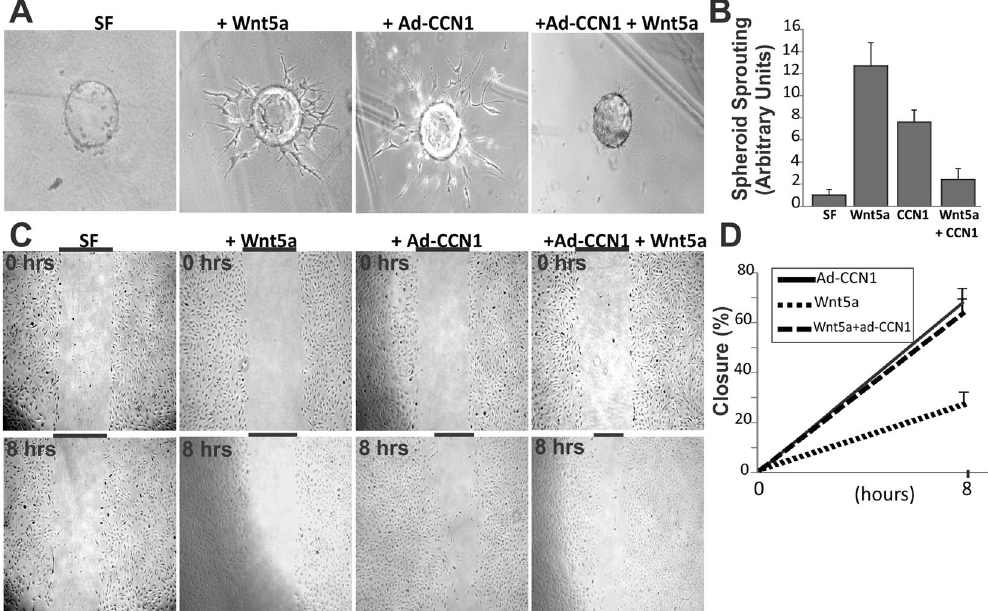
Figure 6. Functional and regulatory relationship between CCN1 and Wnt5a in ECs. ( A , B ) ECs were transduced with Ad-CCN1 or Ad-luc adenoviral vector, allowed to adhere to cytodex beads and then embedded in fibrin gels in the absence and presence of Wnt5a. Sprout formation was monitored by microscopy after 3 days. Quantitative analyses of spheroid sprouting was determined and expressed in arbitrary units. ( C , D ) ECs were pretreated with 5-FU to inhibit cell proliferation and the effect on cell migration was determined with cell scratch test. A representative experiment of the percentage closure from cell front after 8 h is